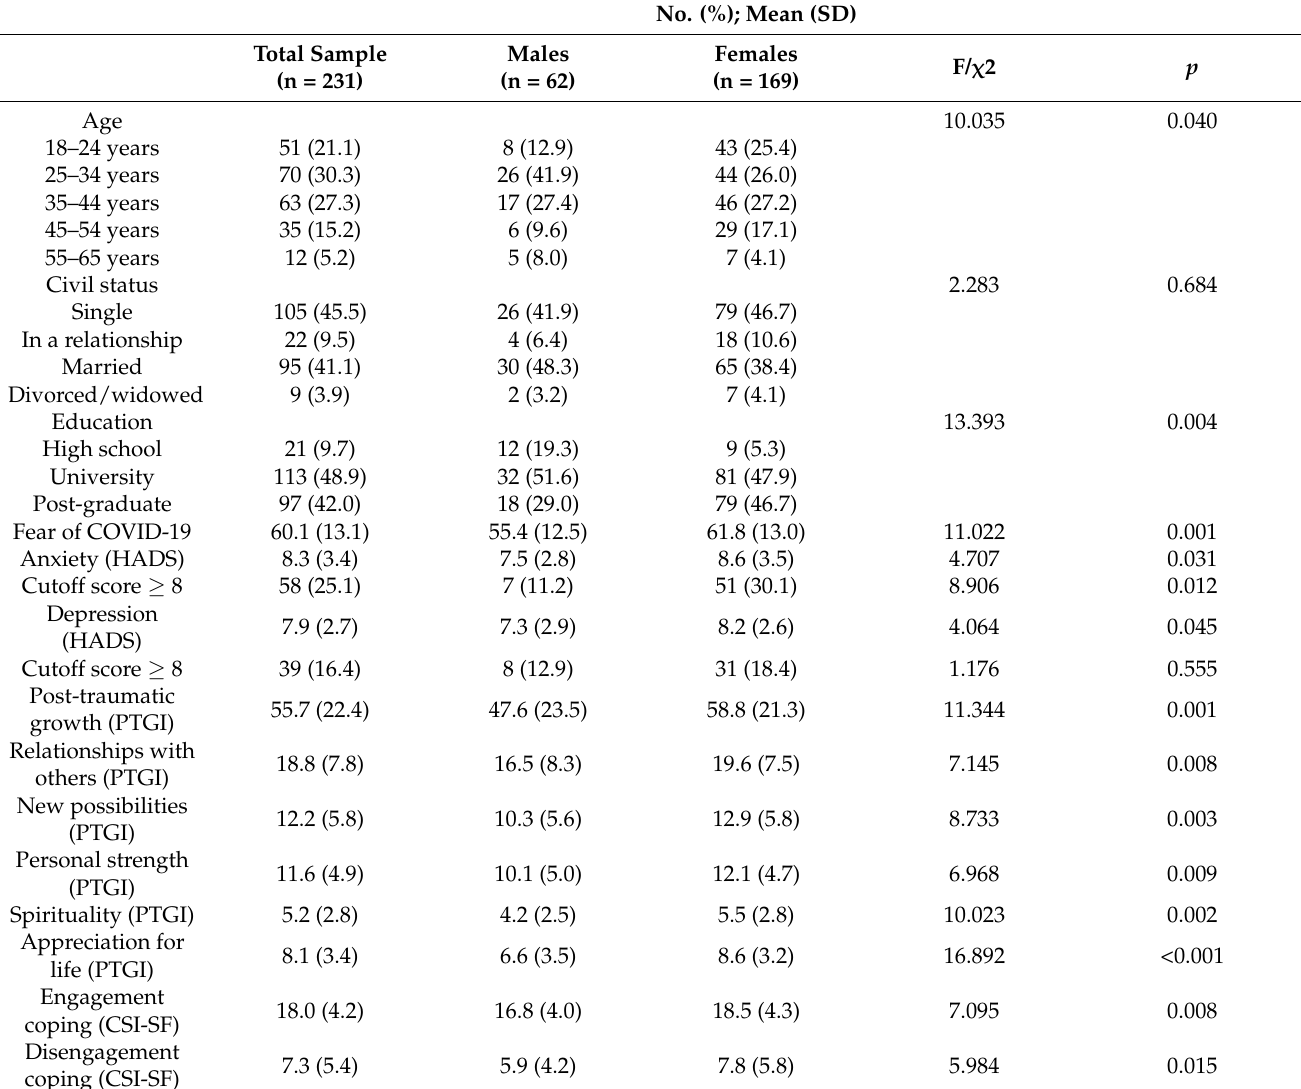
Table 1. Socio-demographic and clinical characteristics of the